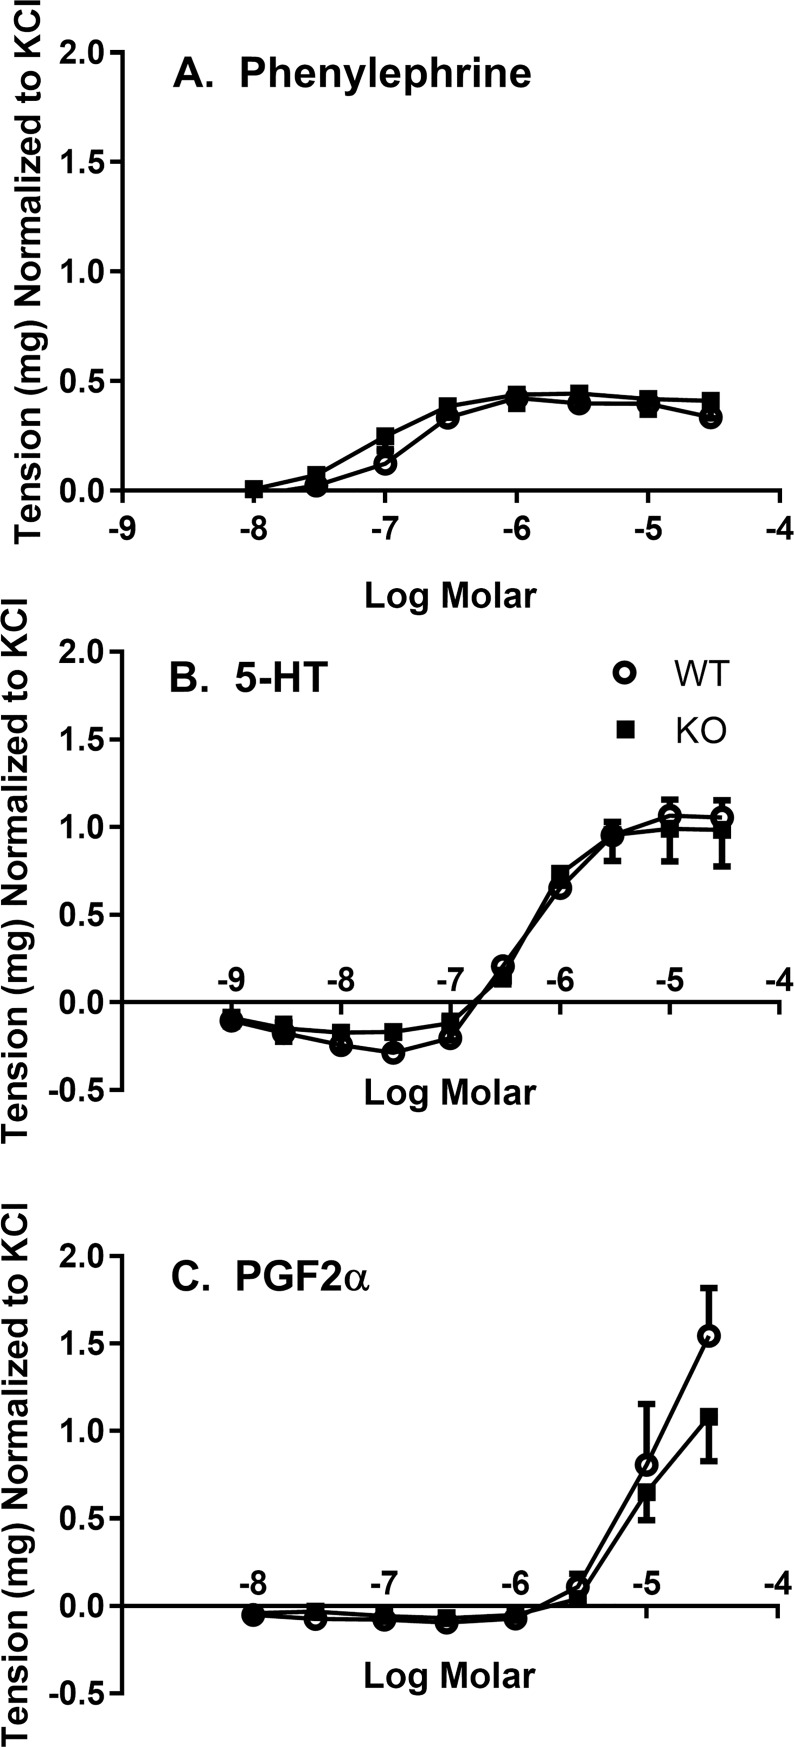
Dose-response curves for receptor-mediated contraction of thoracic aortas isolated from wild-type (WT) and Slc29a1-null (KO) mice.Tissues were incubated for 30 min at 37°C in KPSS buffer at resting tensions of 500 mg after which they were depolarized with 100 mM KCl, washed thrice, and then exposed to increasing concentrations of phenylephrine (Panel A), 5-HT (Panel B) or PGF2α (Panel C). Each point represents the mean ± SEM from 5 independent experiments, and expressed as tension generated normalized to the 100 mM KCl-induced contraction. No significant differences were observed between aortas from wild-type and Slc29a1-null mice in any of the data sets shown (Two-Way ANOVA for paired experimental parameters, P<0.05).